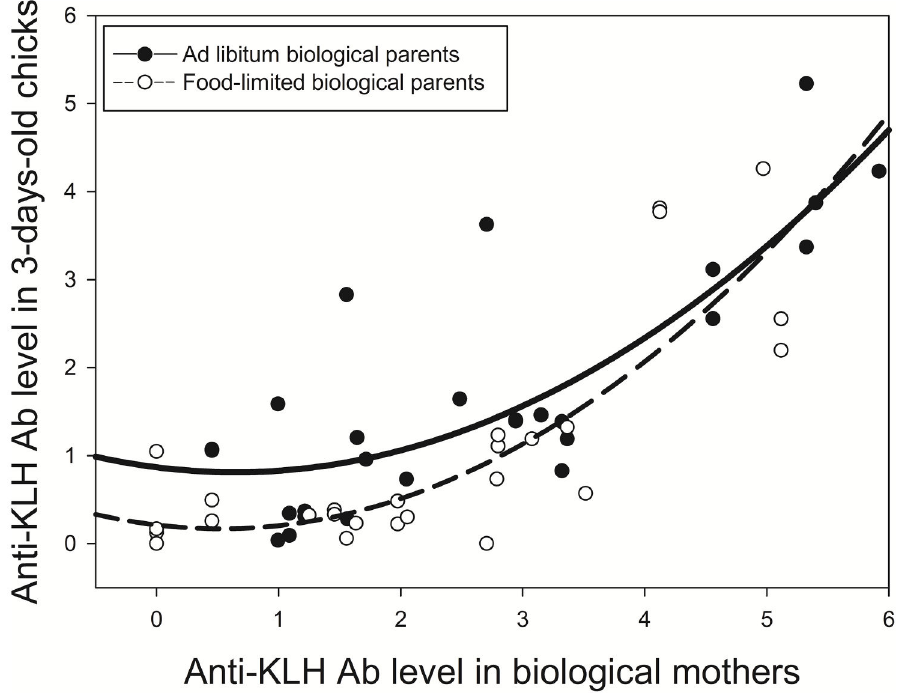
Figure 1. Positive quadratic relationships between anti-KLH Ab levels in 3-day-old chicks and their biological mothers. Dot color indicates food treatment (white = food-limited; black = ad libitum ). doi: